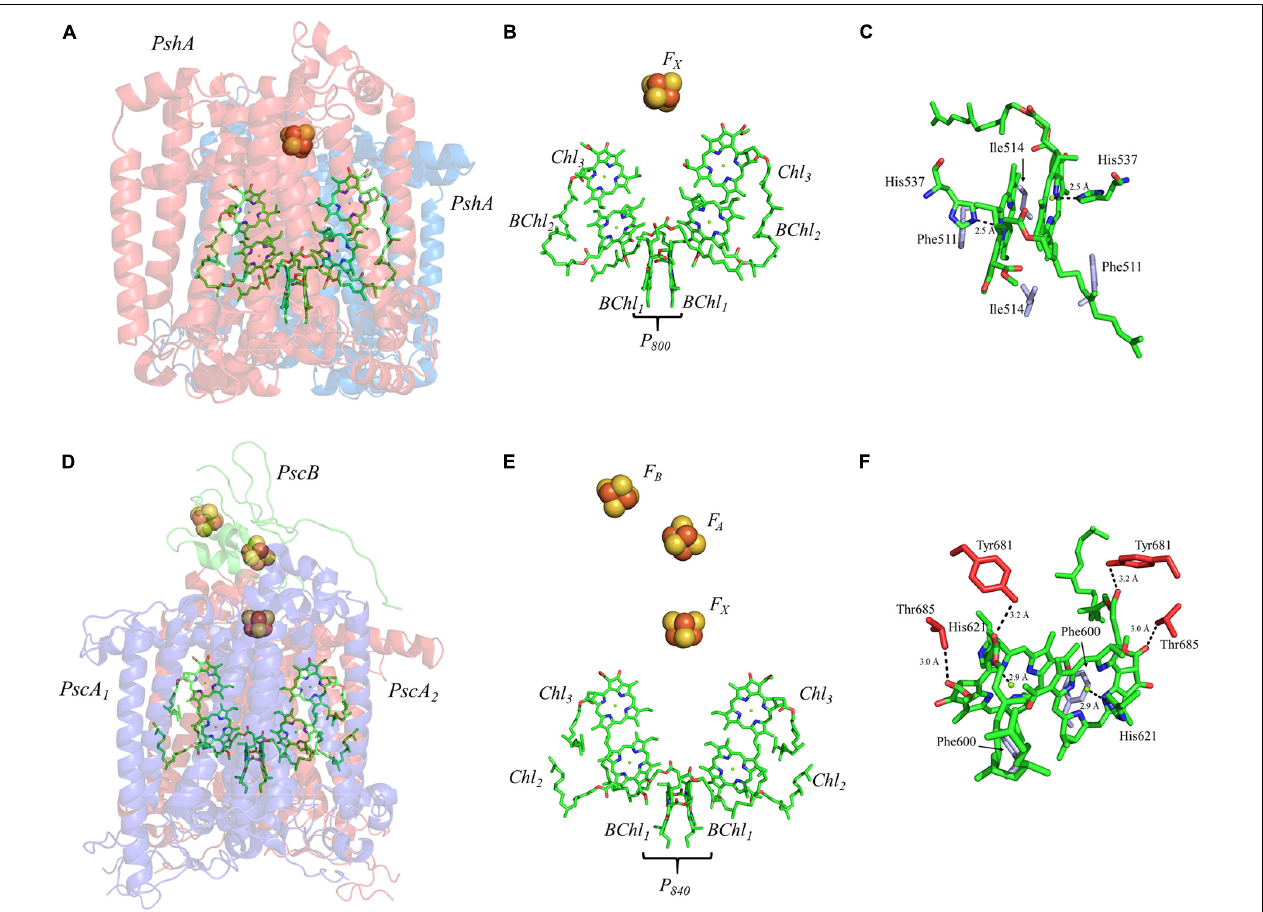
FIGURE 8 | (A) The core subunits (PshA, Blue and Red) and cofactors of the HbRC from H. modesticaldum as observed by X-ray crystallography (PDB ID: 5v8k), (B) the cofactors that participate in the primary electron transfer pathway of the HbRC and (C) the binding pocket of the primary donor, P 800 . (D) The core subunits (PscA 1 , blue; PscA 2 , red; and PscB, green) and cofactors GsbRC from C. tepidum as observed by cryo-electron microscopy (PDB ID: 6m32), (E) the cofactors that participate in the primary electron transfer pathway of the GsbRC and (F) the binding pocket of the primary donor, P 840 . The residues in part (C,F) that are providing hydrogen bonds are shown in red, and nearby non-polar or π -stacked residues are colored in